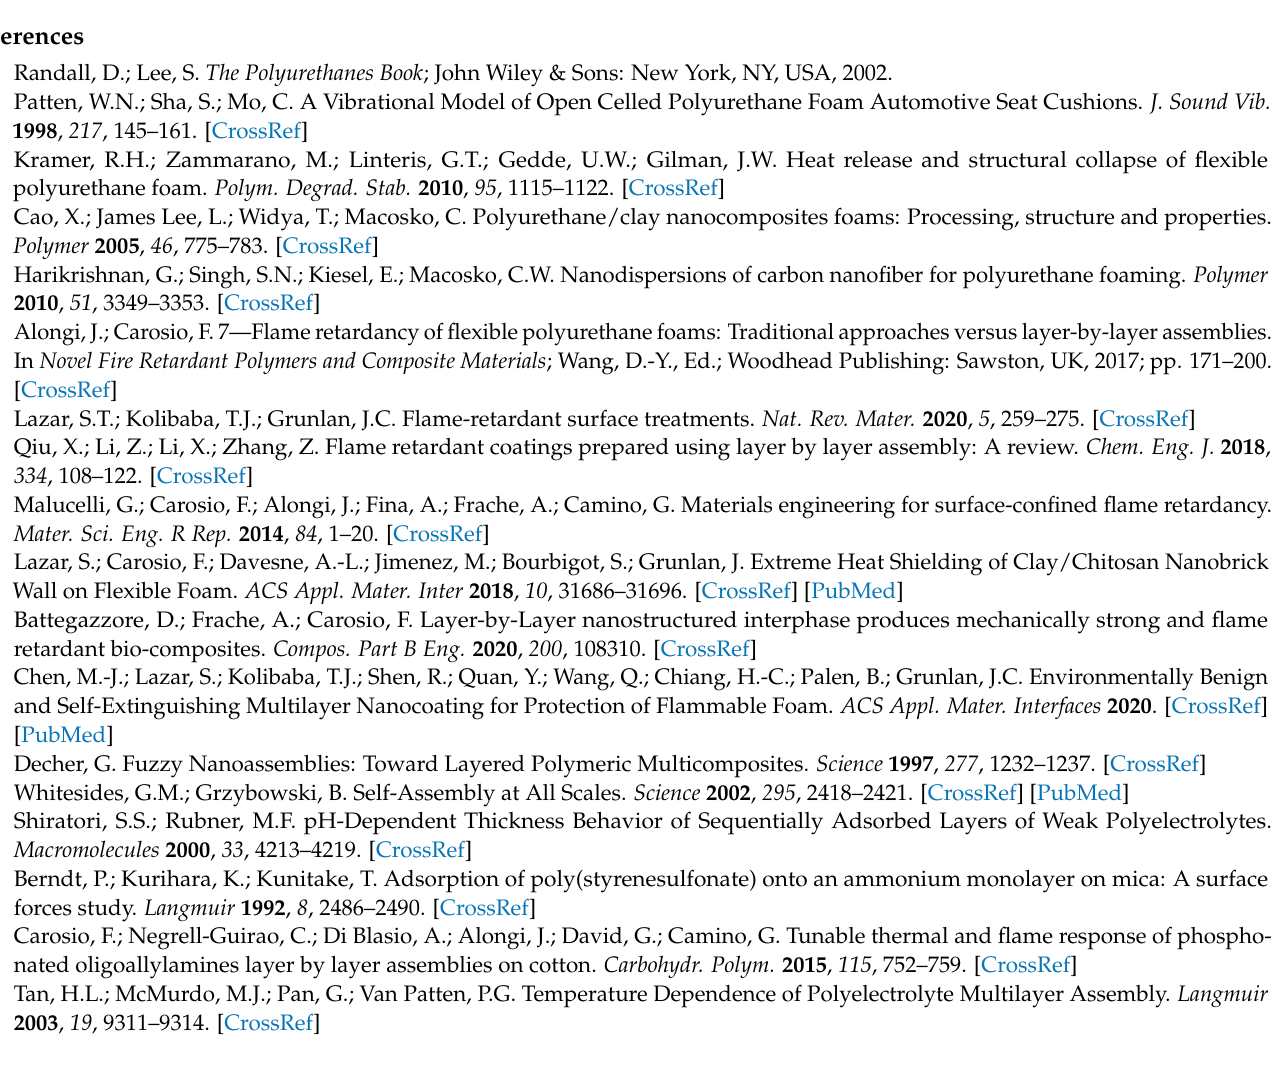
Figure S3 Pictures of flammability test in horizontal configuration of 6BL CHIT/GO A treated PU foam, 6BL CHIT/GO B PU foam and 6BL CHIT/GO C PU foam. First column: right after ignition, second column: 15 s after ignition and third column: end of the